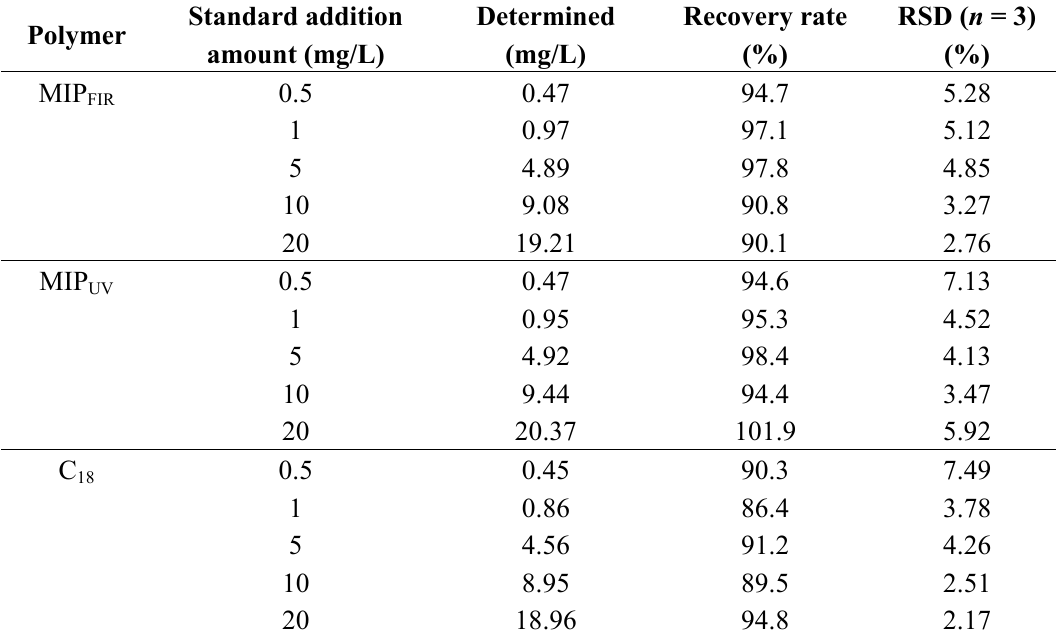
Table 4. Recoveries of atrazine obtained from spiked lake water